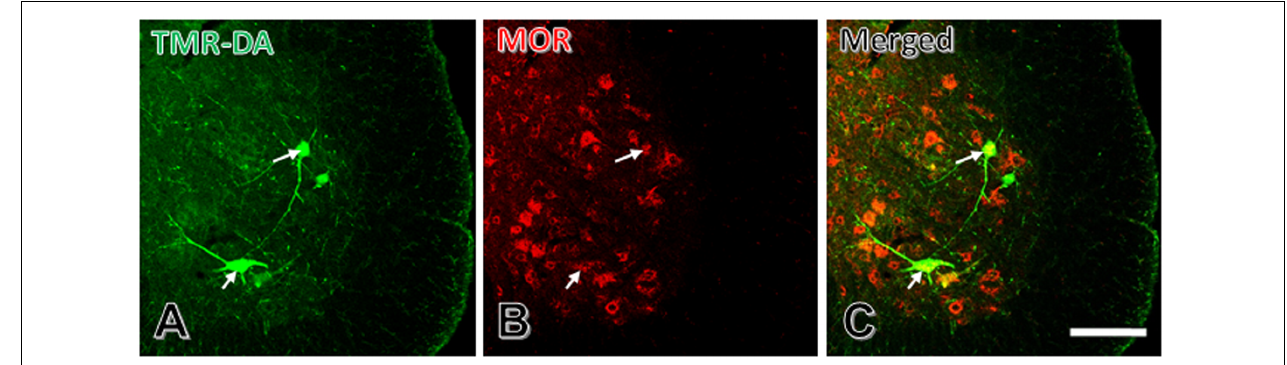
FIGURE 3 | Some spinal ventral horn TMR-DA retrogradely labeled motoneurons are MOR positive. (A) TMR-DA labeled motoneurons in spinal ventral horn. (B) MOR positive motoneurons in spinal ventral horn. (C) Merged image of (A) and (B) . White arrows indicate two TMR-DA and MOR double-labeled neurons. Scale bar = 90 µ m.